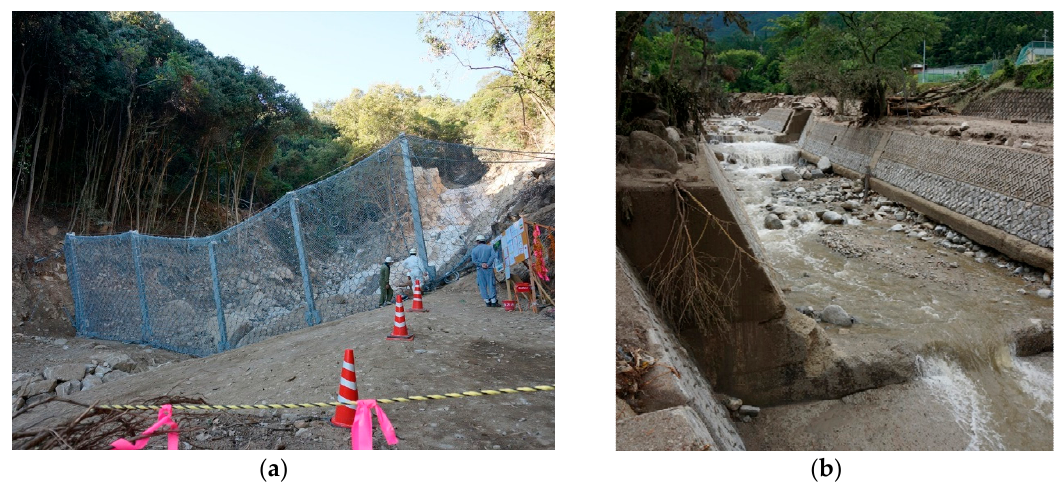
Figure 19. Examples of hard countermeasures of sediment disasters. ( a ) Steel net for capturing small debris flow, ( b ) Channel work.